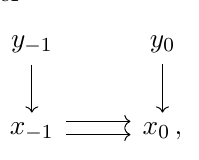
= ( − 1 , 1) . The explicit form of the lim